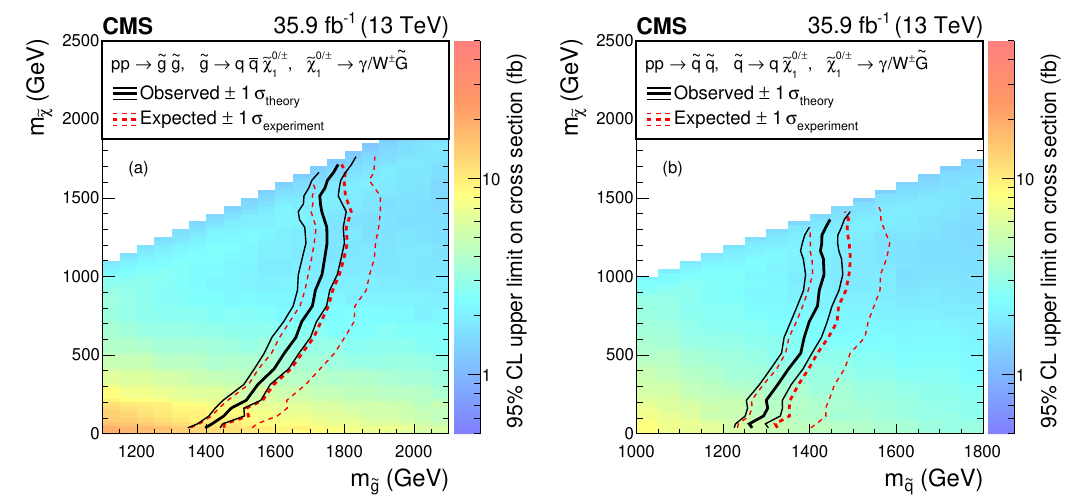
Figure 7 . The observed (solid line) and expected (dashed line) 95% CL exclusion contours for (a) m versus m and (b) m versus m (regions to the left of the curves are excluded), and the e g e (cid:31) e q e (cid:31) 95% CL upper limits on the pair production cross sections for (a) g the T6Wg simpli(cid:12)ed models (use the scales to the right of the plots). The upper limits on the cross sections assume a 50% branching fraction for e around the observed and expected exclusion contours indicate the (cid:6) 1 standard deviation range when including the experimental and theoretical uncertainties, respectively. (cid:31) 0 = (cid:31) (cid:6) masses, gluino (squark) masses are excluded at 95% CL up to 1.75 (1.43) TeV in the T5Wg (T6Wg) e e